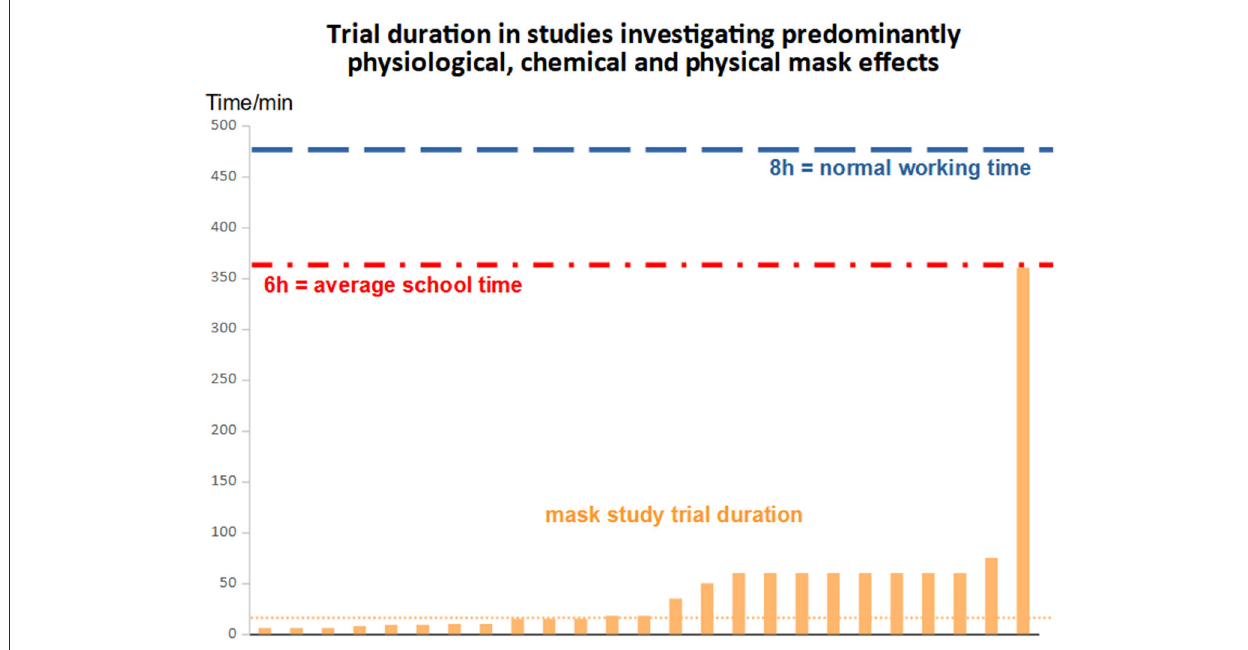
FIGURE11 Illustration of the duration of studies in which measurements were made on mask effects (physical, biochemical, and physiological) in 934 participants. The median is 18min (yellow dotted line) with an interquartile range of 50. The study with the longest experimental duration included 21 subjects, corresponding to 2.2% of the total population studied. Striking not only is a very short trial time compared to the everyday scenarios workday and school attendance (see interrupted, auxiliary lines in blue and red), but also a strongly deviating mask exposure duration with outliers (mean of 45.8min with standard deviation of 69.9). Therefore, the mean is not an appropriate parameter to characterize this